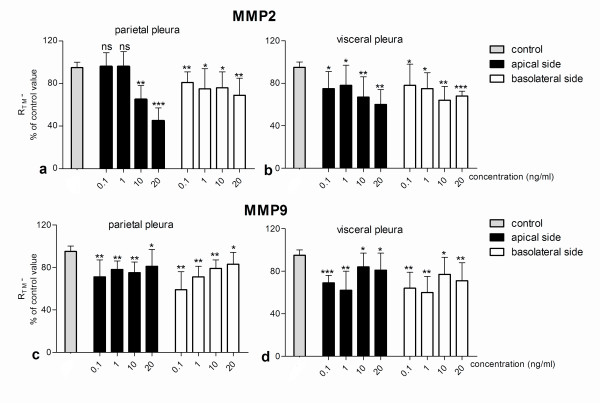
Dose-dependent decrease in transmesothelial resistance (RTM) of sheep pleura after the addition of MMP2 or MMP9. Different concentrations (0.1, 1, 10 and 20 ng/ml) of MMP2 and MMP9 were added at parietal and visceral pleura and on the apical and basolateral side and the RTM was measured on the 40 min. The changes in RTM are expressed as percentage difference of the control value (100%), which is the RTM value just before the addition of MMP. Data are given as mean ± SD (n = 6). ns: non-significant, * p < 0.05, ** p < 0.001 and *** p < 0.0001 compared to control RTM (paired t-test).